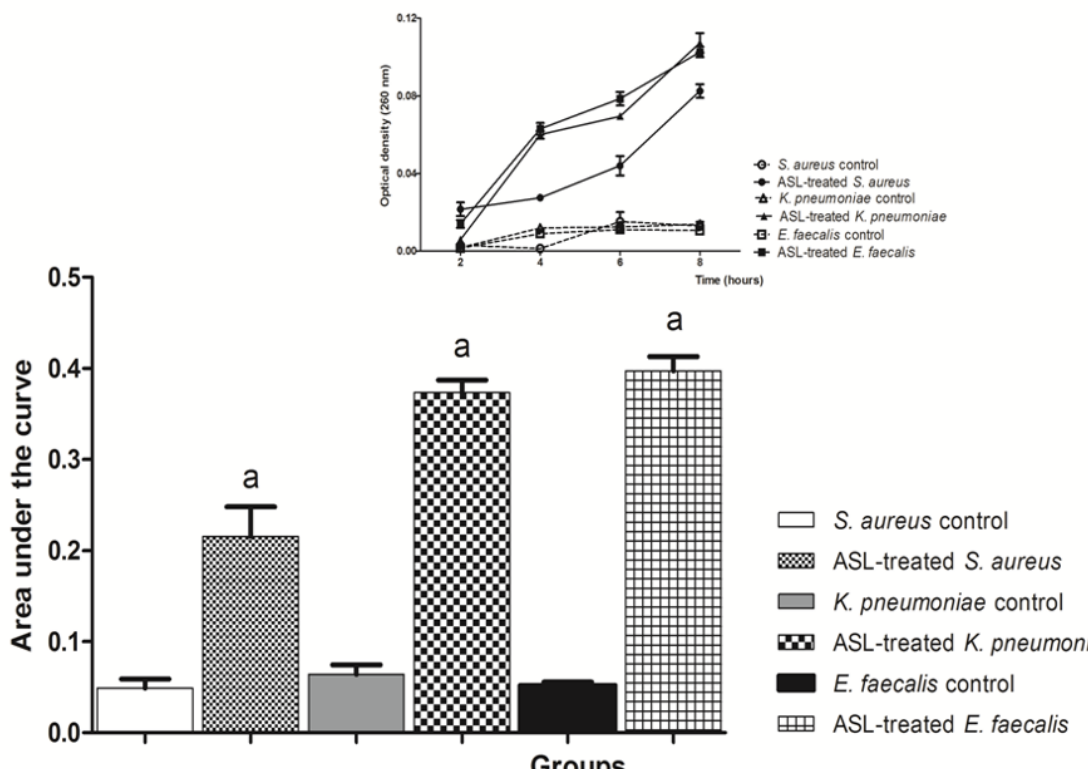
Figure 6 - Mode of action of methanolic extract of Annona squamosa leaves (ASL). Effect of ASL on the amount of the total nucleotide released from S. aureus , K. pneumoniae and E. faecalis . a Statistically different from respective growth controls. b Statistically different from ASL-treated S. aureus (ANOVA followed by Bonferroni, P < 0.05). All experiments were carried out in triplicate, and average values are reported. Error bars refer to the standard